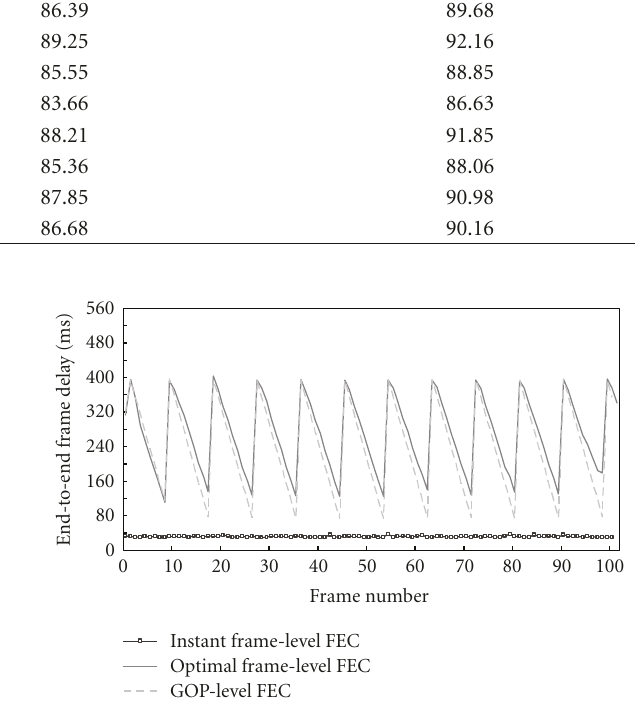
Figure 10: End-to-end timing between frames 1–100 with param- eters P B = 0.01, P b = 10 − 6